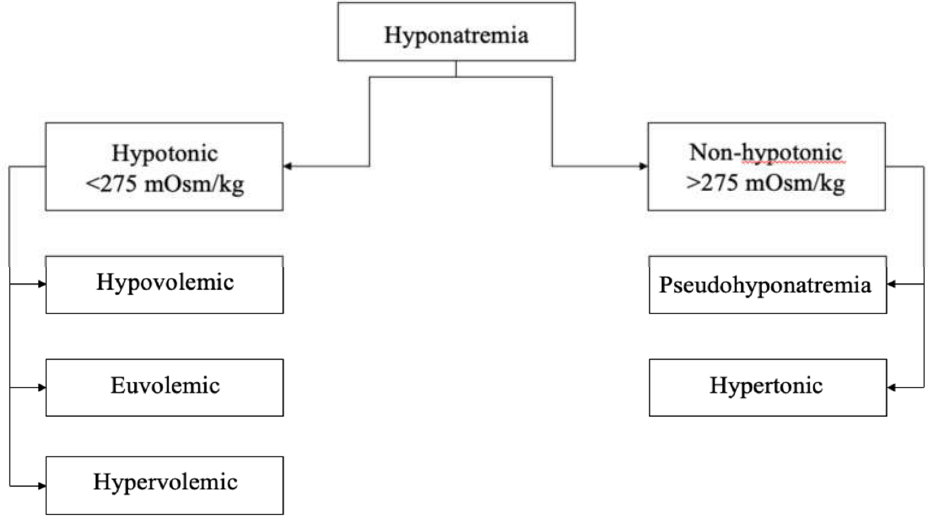
Figure 1. Types of Figure 1. Types of hyponatremia.